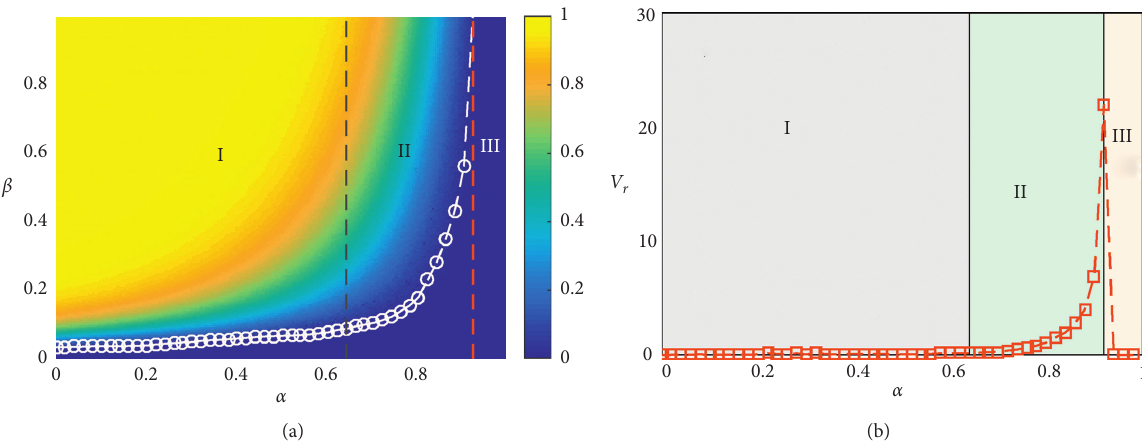
Figure 2: Dependence of ρ on parameters α and β . (a) The phase diagram in parameter plane ( α − β ) . Colors-coded values ρ obtained from Monte Carlo simulations. The epidemic threshold β c is represented by the white circles. Phases I, II, and III are separated by two critical values α I c ≈ 0 . 64 and α II c ≈ 0 . 92, which are marked by the black segment and red segment, respectively. (b) The change rate of the epidemic threshold v r as a function of v r α . Phases I, II, and III are separated by α I c and α II c . The other parameters are set to be δ � 0 . 5, η � 0 . 001, ε � 0 . 6, � 0 . 8, respectively. μ � 0 . 1, and q 0